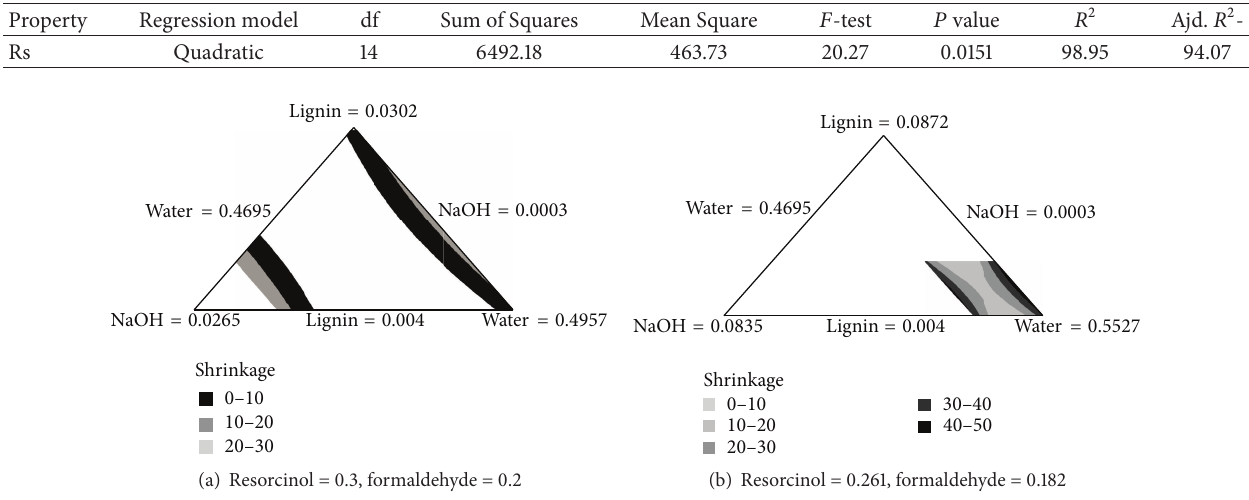
Figure 2: Contour plots for shrinkage: (a) 𝑅/𝐹 mass ratio 1.5; (b) 𝑅/𝐹 mass ratio 1.4.